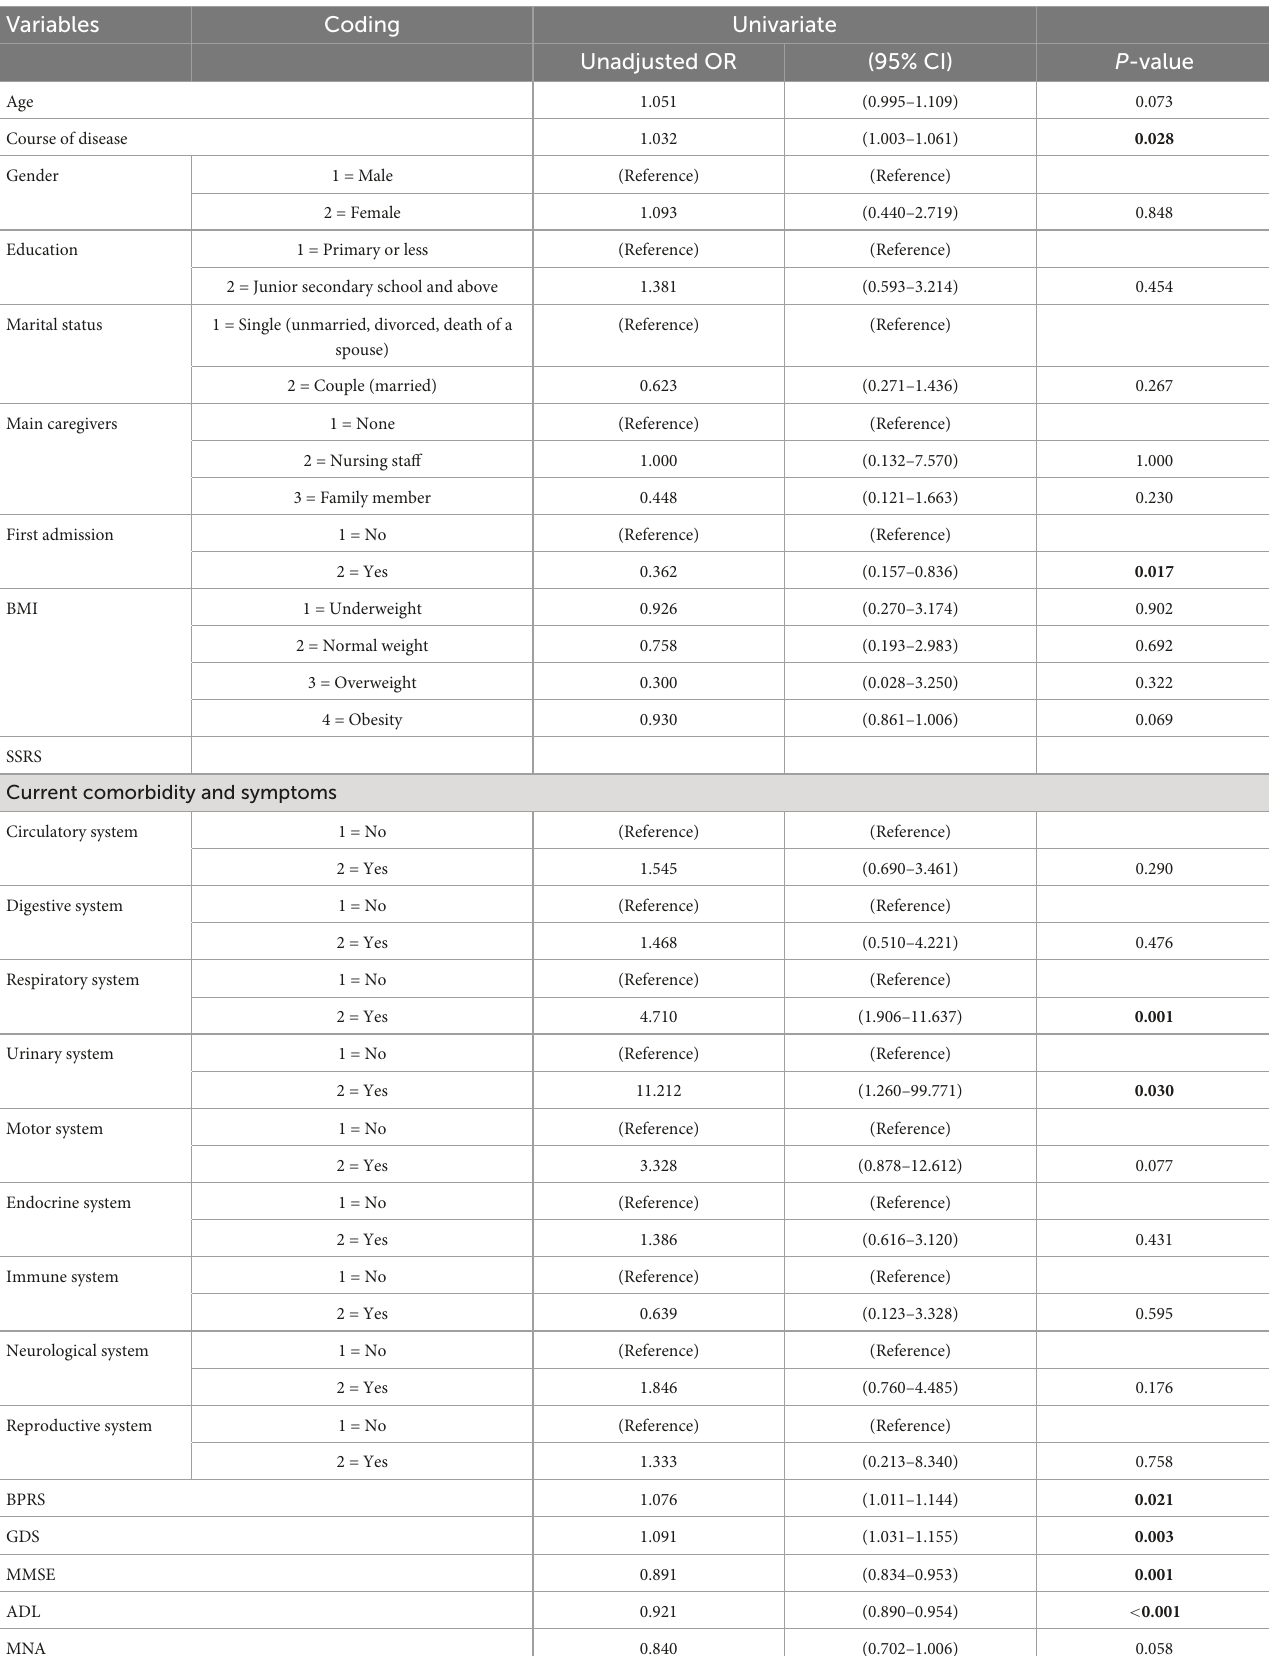
TABLE 2 Binomial logistic regression showing the crude risk of dependent function